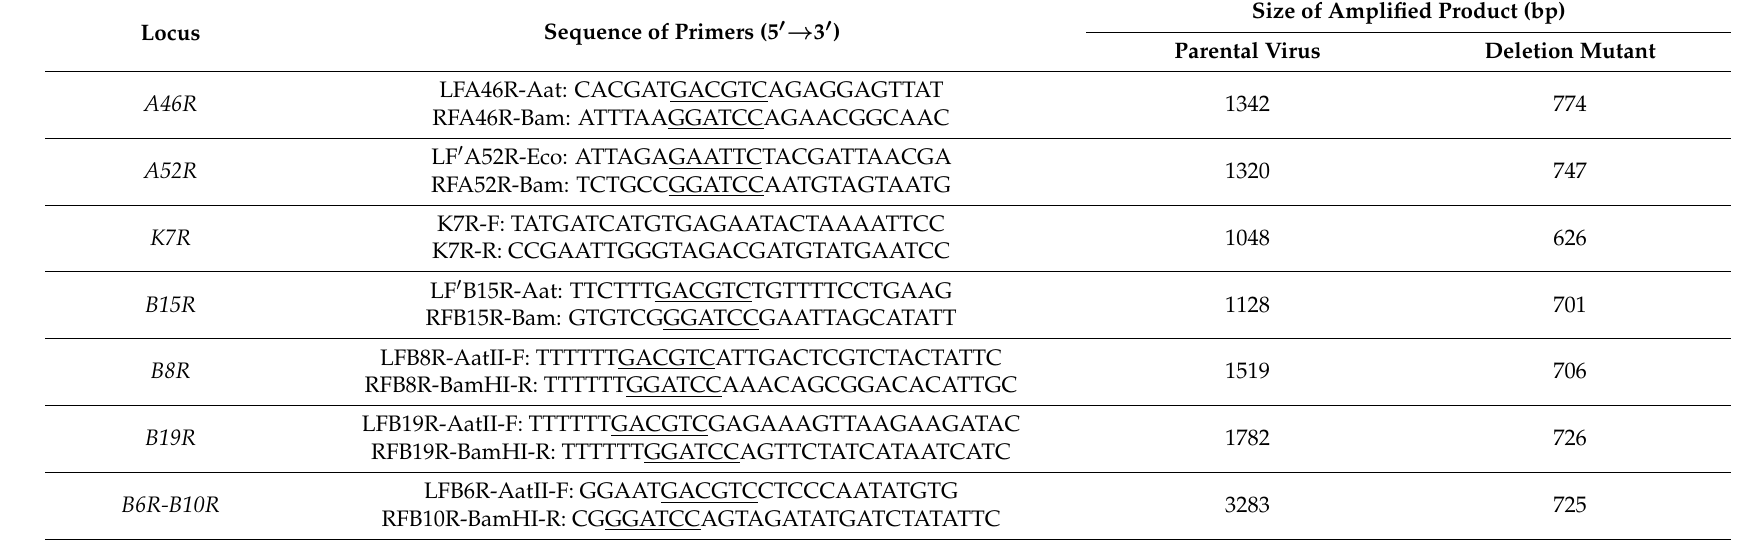
Table 2. Primers used for the deletion/confirmation of deletion by PCR of A46R , A52R , K7R , B15R , B8R , B19R and B6R-B10R open reading frames (ORFs). Restriction enzymes cleavage sites are